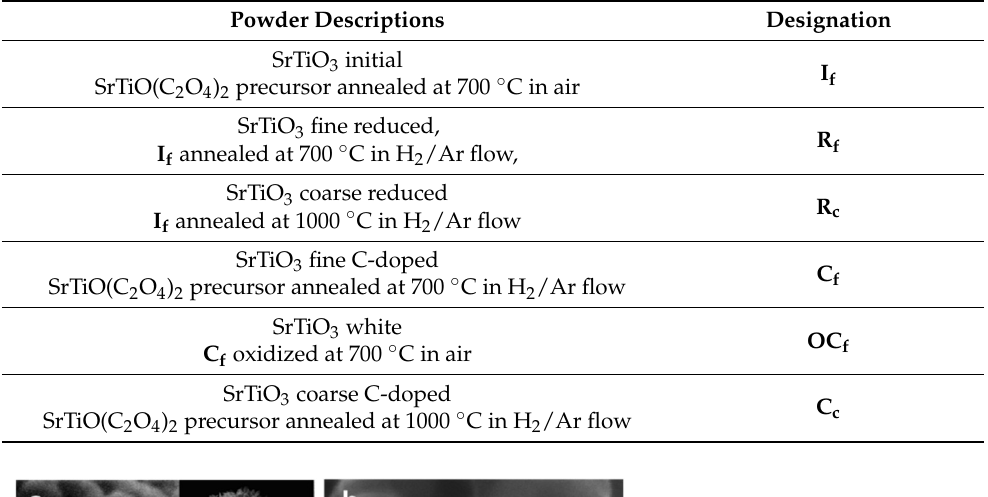
Table 1. Sample description and notations.